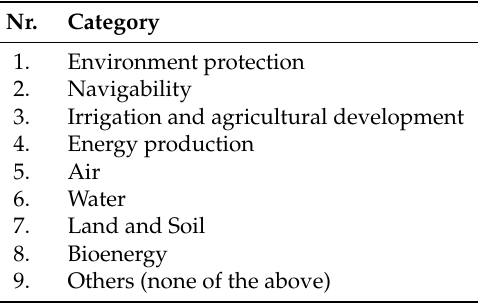
Table 1. List of categories for identification of possible data gaps. Source [29]. Nr. Category 1.